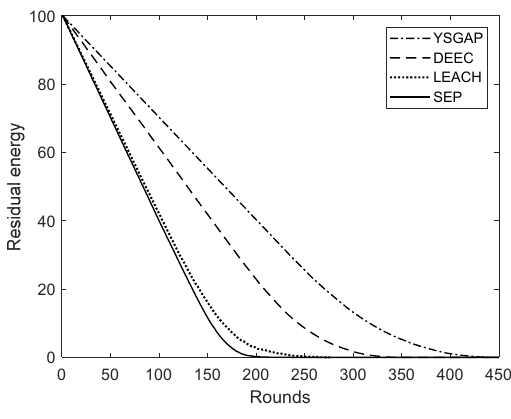
Figure 5. Total residual energy.